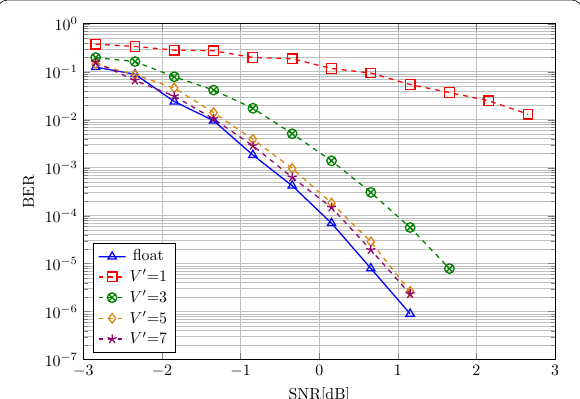
Fig. 8 AM readout-quantization 1/4 rate HDM soft-feedback decoder with D = 512 , N = 512 , and V = 7